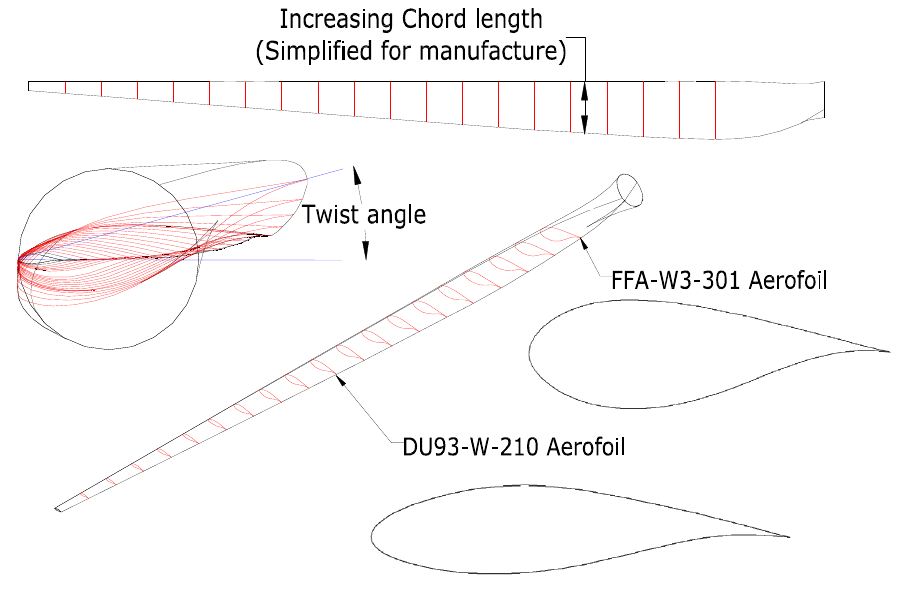
Figure 8. A typical modern HAWT blade with multiple aerofoil profiles, twist and linear chord length